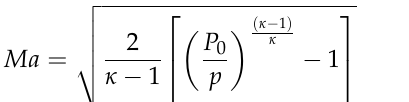
Figure 1. Structure diagram of the supersonic combustion coherent jet nozzle.